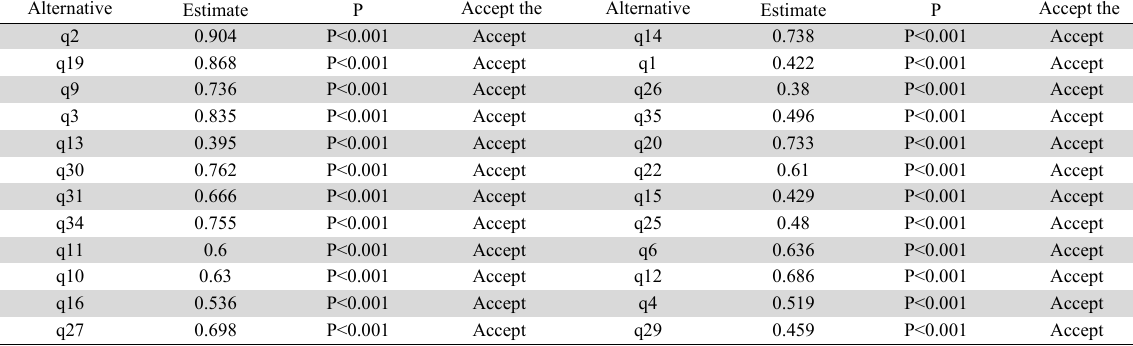
Extraction Method: Principal Component Analysis. Rotation Method: Varimax with Kaiser Normalization. a. Rotation converged in 7